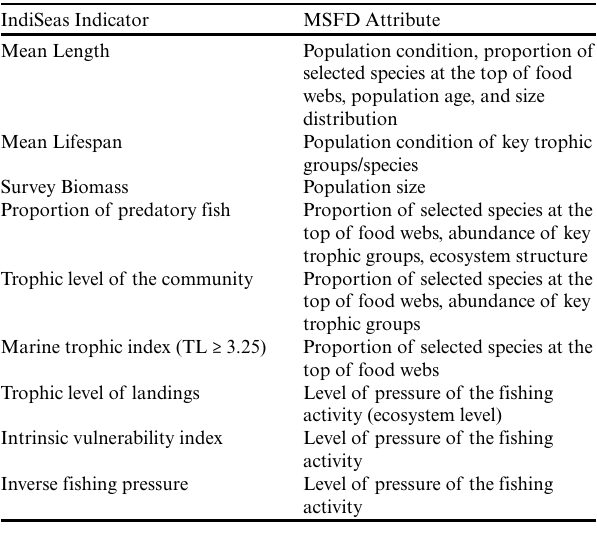
Table 4 . IndiSeas indicators and the corresponding attributes of the Marine Strategy Framework Directive (MSFD) for assessing good environmental status. Adjusted from MEECE